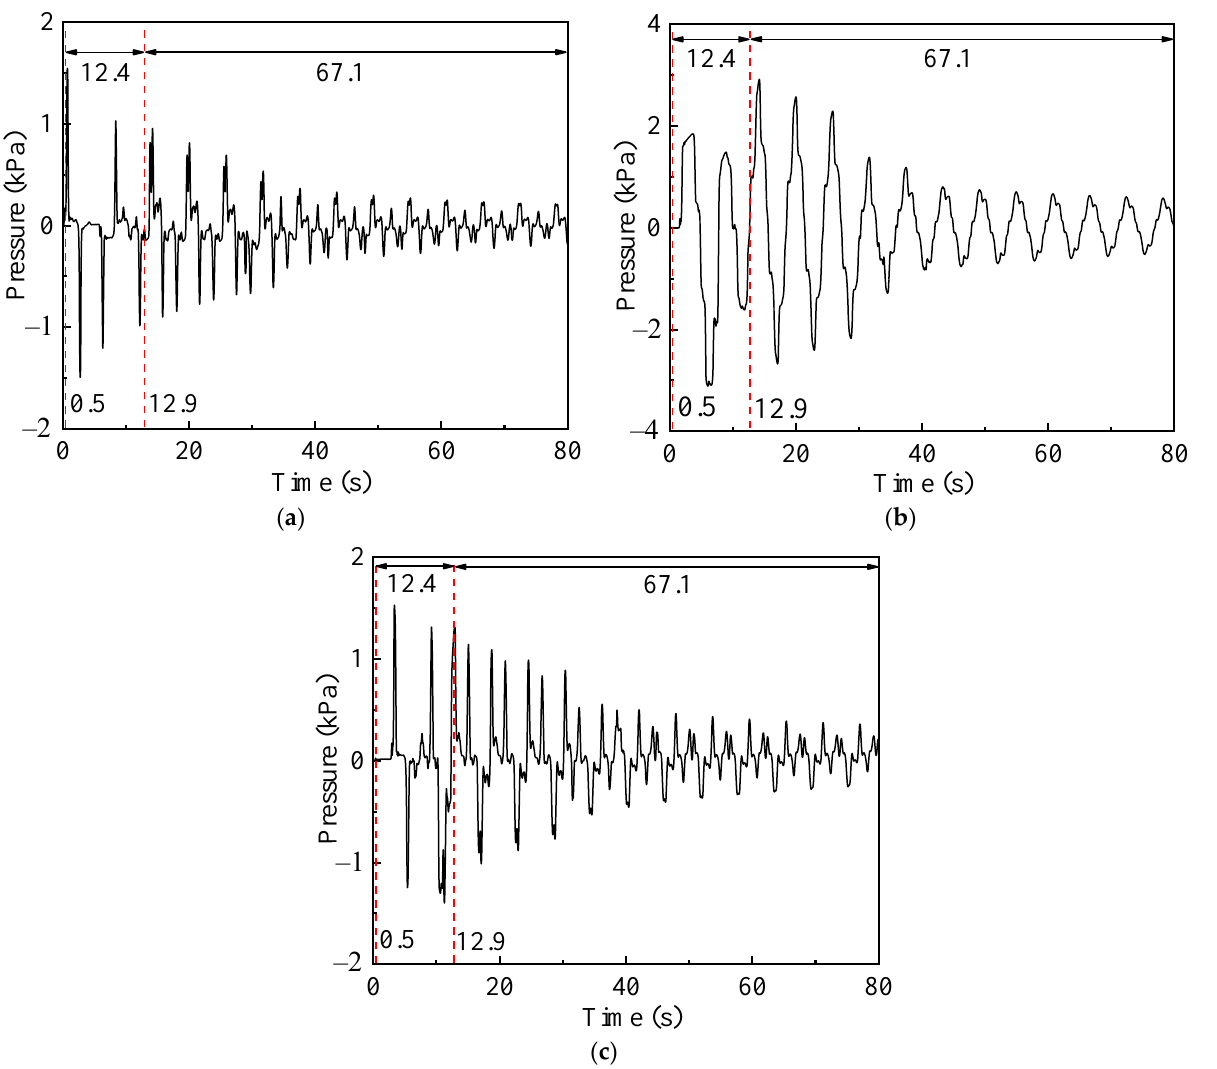
Figure 11. Aerodynamic pressures time histories for typical monitoring points ( v = 350 km/h). ( a ) Monitoring point 2-V; ( b ) Monitoring point 10-V; ( c ) Monitoring point 17-V .